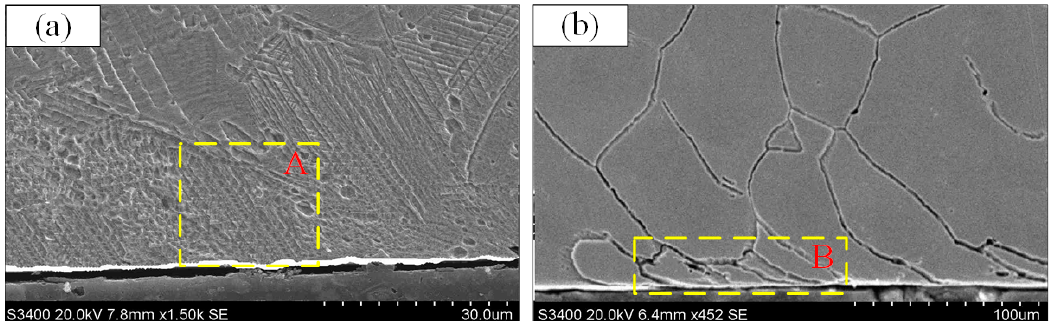
Figure 13. SEM image close to the machined surface for sample 9: ( a ) area A; ( b ) area B.